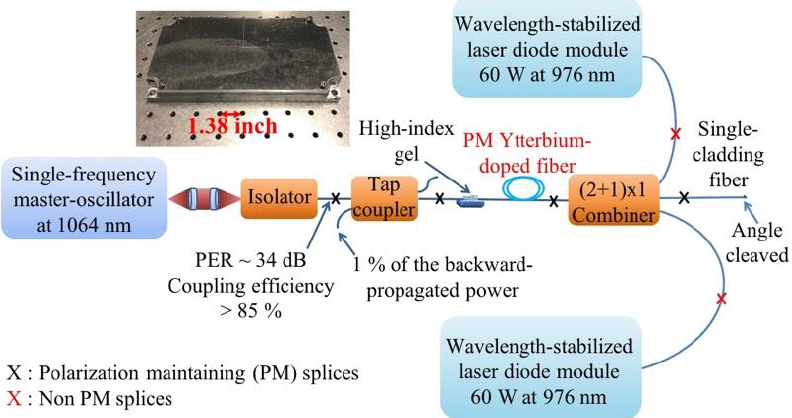
Figure 2. Schematic of the double-clad Yb-doped MOPA fiber amplifier. Photograph shows the packaged amplifier.